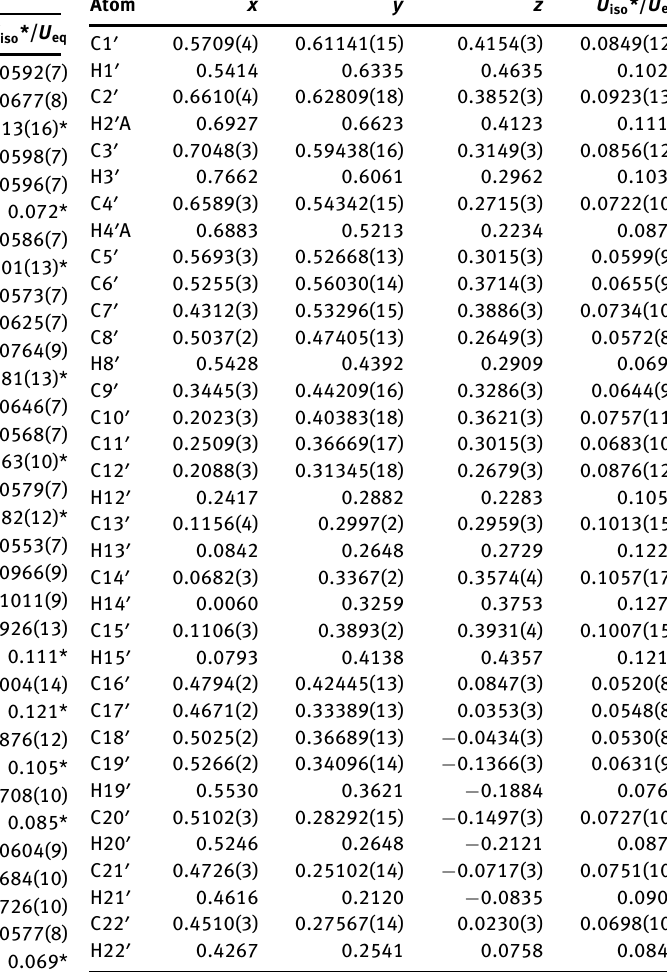
Table 2: Fractional atomic coordinates and isotropic or equivalent isotropic displacement parameters (Å 2